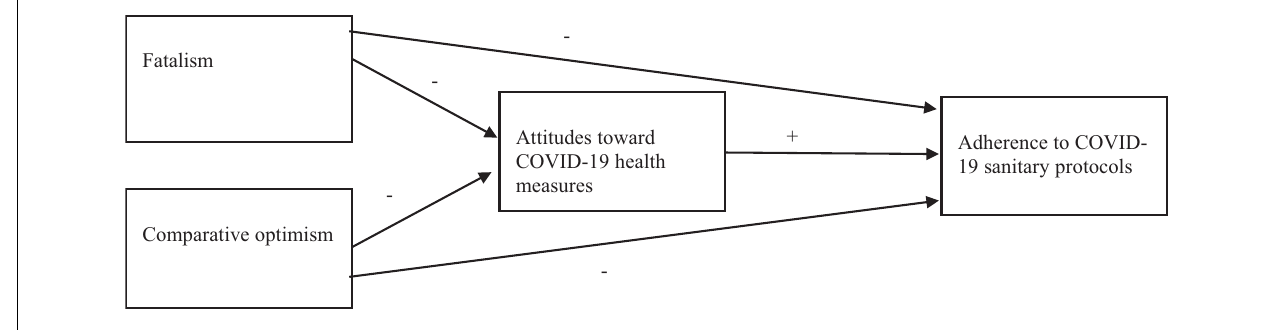
FIGURE 1 | Heuristic working model of the study. − Hypothesized negative association +Hypothesized positive association.